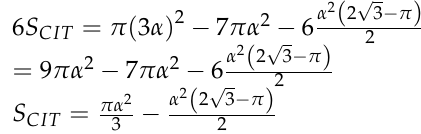
We define the area of the curved isosceles triangle, e.g., CIT as: